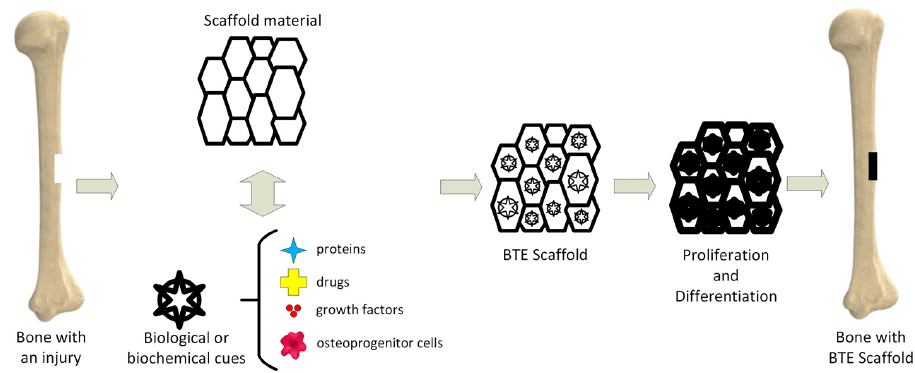
Figure 1. Bone tissue engineering (BTE) principle.